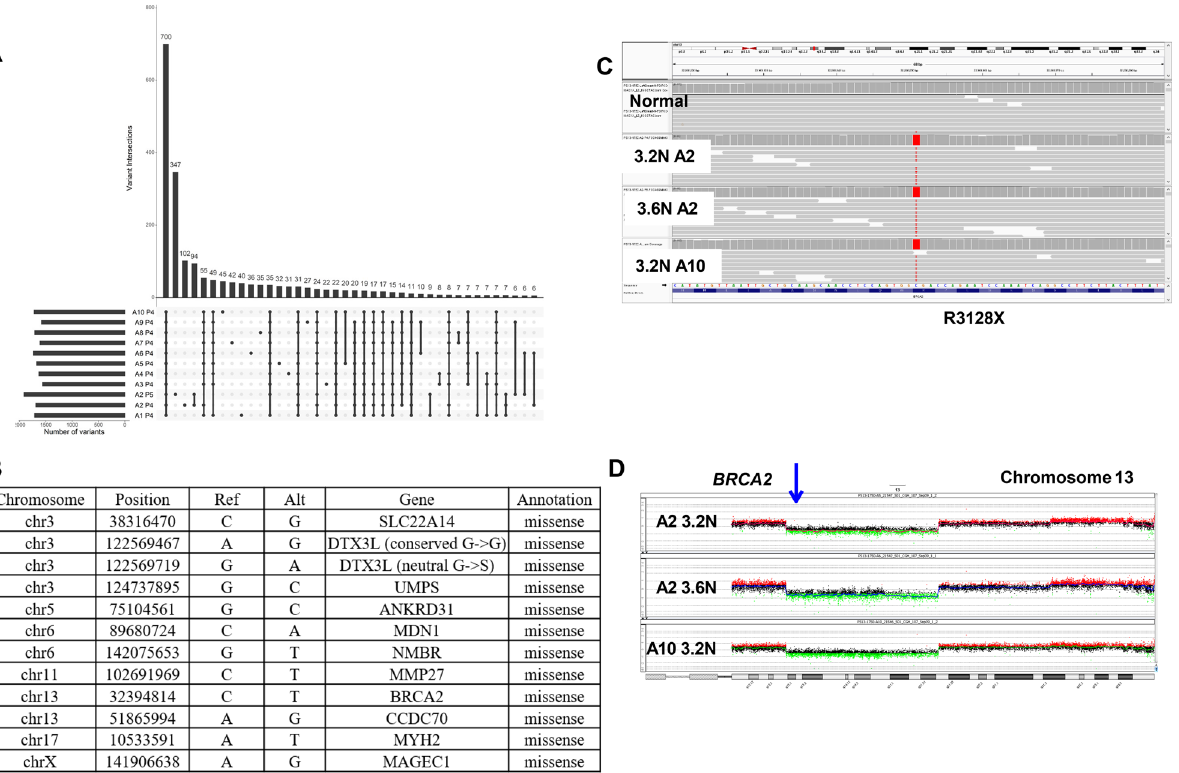
Figure 2. Genomic analysis of somatic BRCA2 mutant PS13-1750. ( A ) Upset plot displaying patterns of variant sharing among samples in flow sorted biopsies. ( B ) Shared fixed coding and non-synonymous somatic variants within the tumor. ( C ) IGV view of BRCA2 in normal, 3.2 N populations flow sorted from biopsies A2 and A10, and 3.6 N population in A2. ( D ) Chromosome 13 CNV plots for 3.2 N populations flow sorted from biopsies A2 and A10, and 3.6 N population in A2. Blue arrow denotes BRCA2 locus that maps to interstitial deletion of 13q13.1–q21.32 in each export Smad3 (a component of TGFβ signaling) and Eif5a1 and Eif5a2 (two closely related translation initiation factors) from the nucleus, was also shared 27,28 . This gene has been identified as a tumor suppressor in hepatocel- lular carcinoma 29 . Four additional shared fixed variants within non-coding regions mapped to the two highest amplicons across the tumor on chromosome 12p13.32 and 12q14.1 and reflect the stability of these CNVs. There were 3 additional node-specific shared fixed variants including two on chromosome 13, a missense variant CCD‑ C168 D4512N and a variant in an intergenic region, and an intronic variant of MYO15A at 17p11.2. A striking finding in the BRCA WT tumor PS13-585 was the presence of aberrant CNV patterns but stable genomes across the primary and nodal tissues and multiple ploidies (Fig. 4C). The genomes of each of the 24 sorted aneuploid populations in this tumor shared a high level 20q11.23–q12 amplicon targeting SRC , a chro- mosome 12 with multiple amplicons and deletions, including a large homozygous deletion spanning 9.5 Mb at 3p12.1–p12.3 that targeted the axon guidance Roundabout Guidance Receptors 1 and 2 ( ROBO1 and ROBO2 ) loci